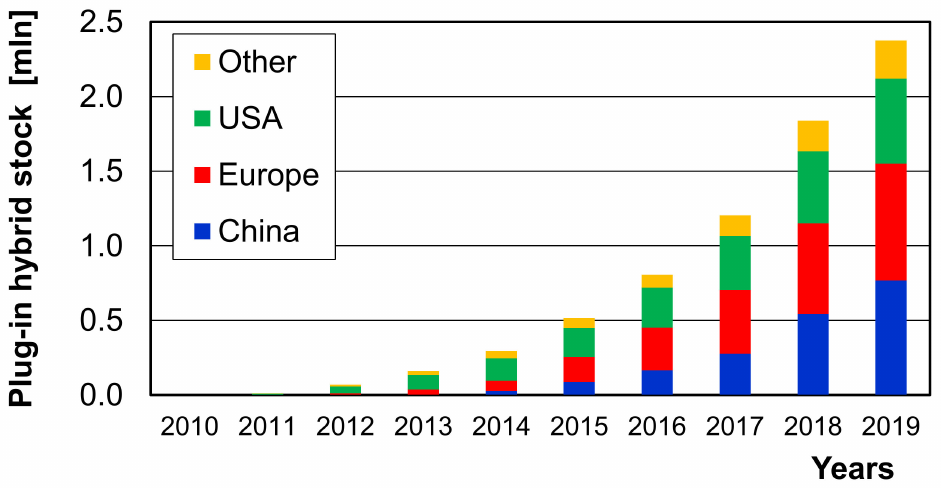
Figure 1. Increasing the number of plug-in hybrid vehicles between 2010 and 2019 globally (based on